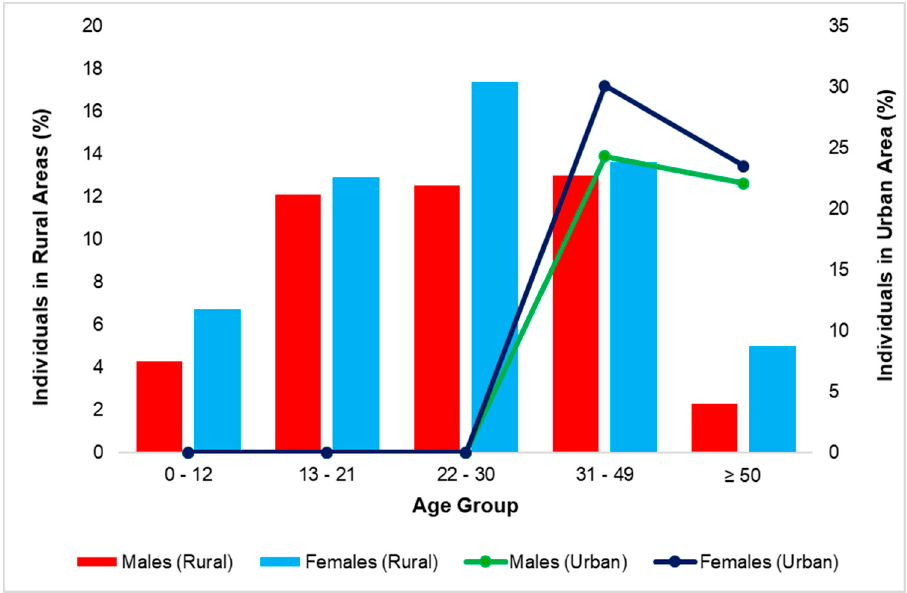
Figure 2. Population distribution of the selected areas at Ugu District Municipality during the study period.